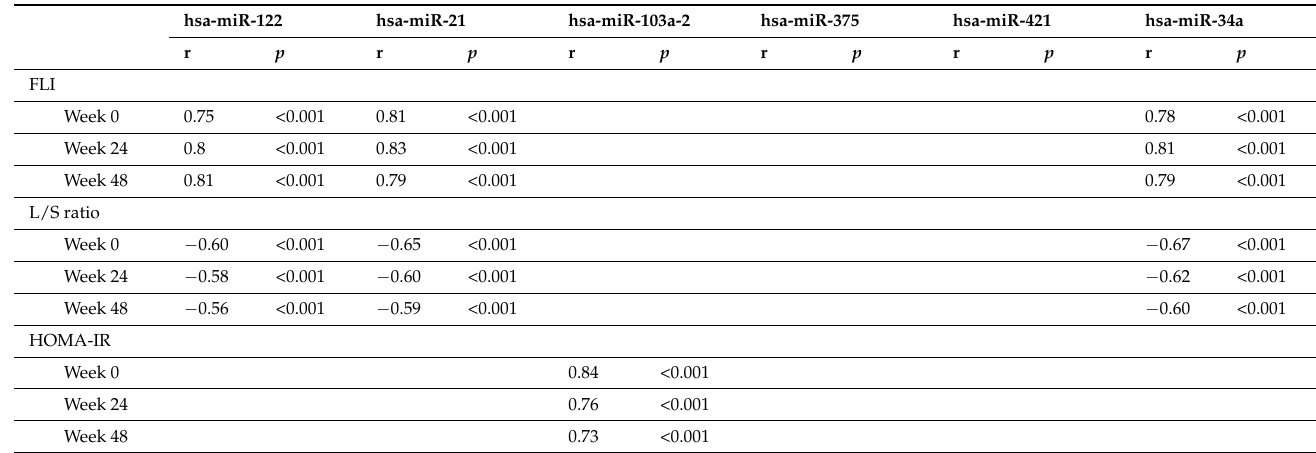
Table 4. Correlation between microRNAs and relevant biochemical